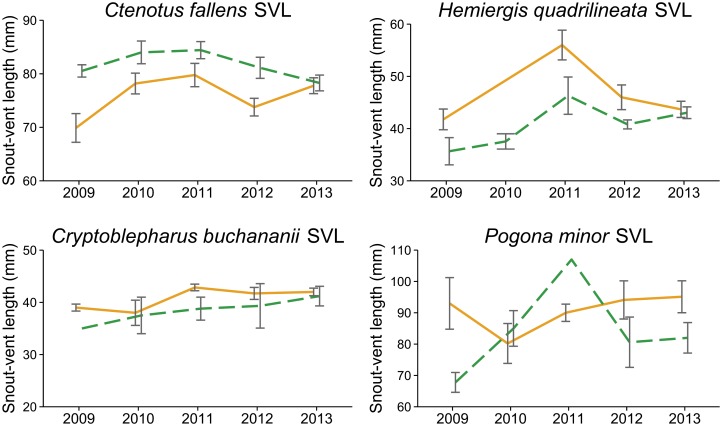
Mean snout-vent length (SVL) for the three most common species at burnt (solid orange line) and unburnt (dashed green line) sites in each year.